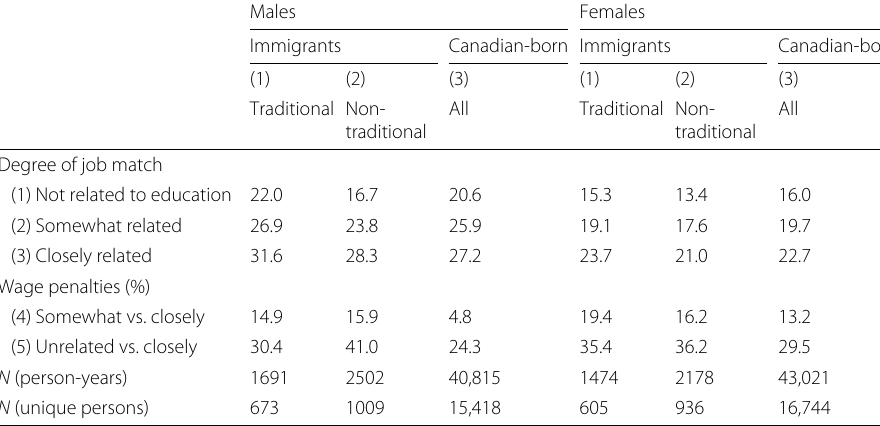
Males Females Immigrants Canadian-born Immigrants